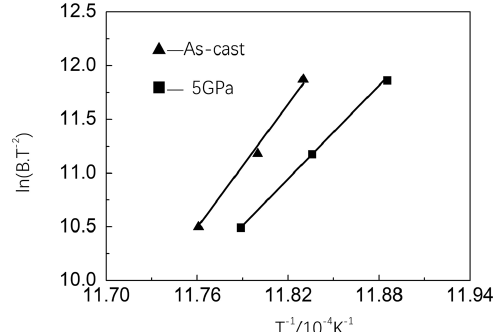
Fig. 5 - Plots of ln(B.T -2 )~T -1 at DSC peak value of Cu-Al alloy before and after high pressure treatment under different heating rates